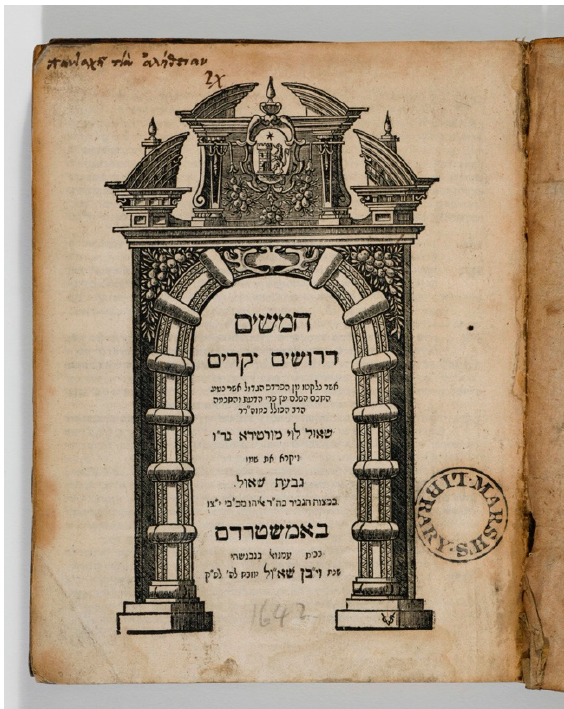
Figure 24. Giveat Shaul, Saul’s Gibeah; Marsh’s Library B.3.3.38.